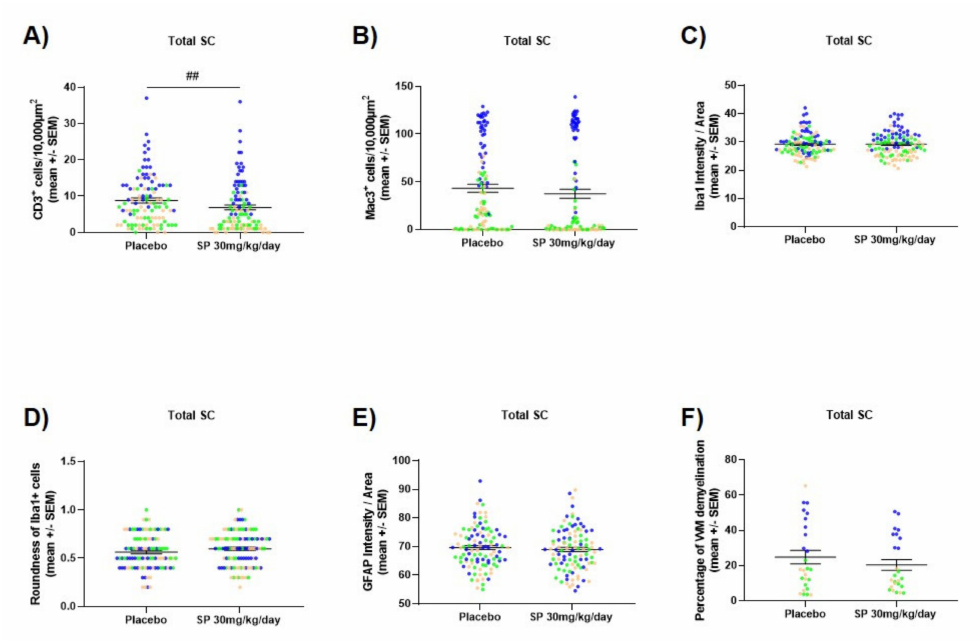
Figure 4. E ff ect of SP treatment on murine spinal cord ( A ) CD3 + cell infiltration, ( B ) Mac3 + cell infiltration, ( C ) Iba1 fluorescence intensity, ( D ) Iba1 + cell roundness, ( E ) GFAP fluorescence intensity and( F )whitematterdemyelination. SpinalcordswereextractedfromcontrolorSP30mg / kg / day-treated MOG 35-55 EAE-diseased mice (acute phase). Three segments of each spinal cord (cervical, thoracic and lumbar) were evaluated and pooled. For each segment, four di ff erent regions of interest were analyzed except for demyelination where the complete white matter was analyzed. Control (n = 9), SP 30 mg / kg / day ( n = 9) and 3 days of treatment. ( A – B ) immunohistochemistry, ( C – E ) immunofluorescence and ( F ) luxol fast blue staining. Each dot represents a measurement. Orange dots show measurements of the cervical segment, green of the thoracic segment and blue of the lumbar segment of the spinal cord. Abbreviations: SC: Spinal cord, SEM: Standard error of the mean, SP: SP600125 and WM: White matter. Statistic: Mann–Whitney test, ## <